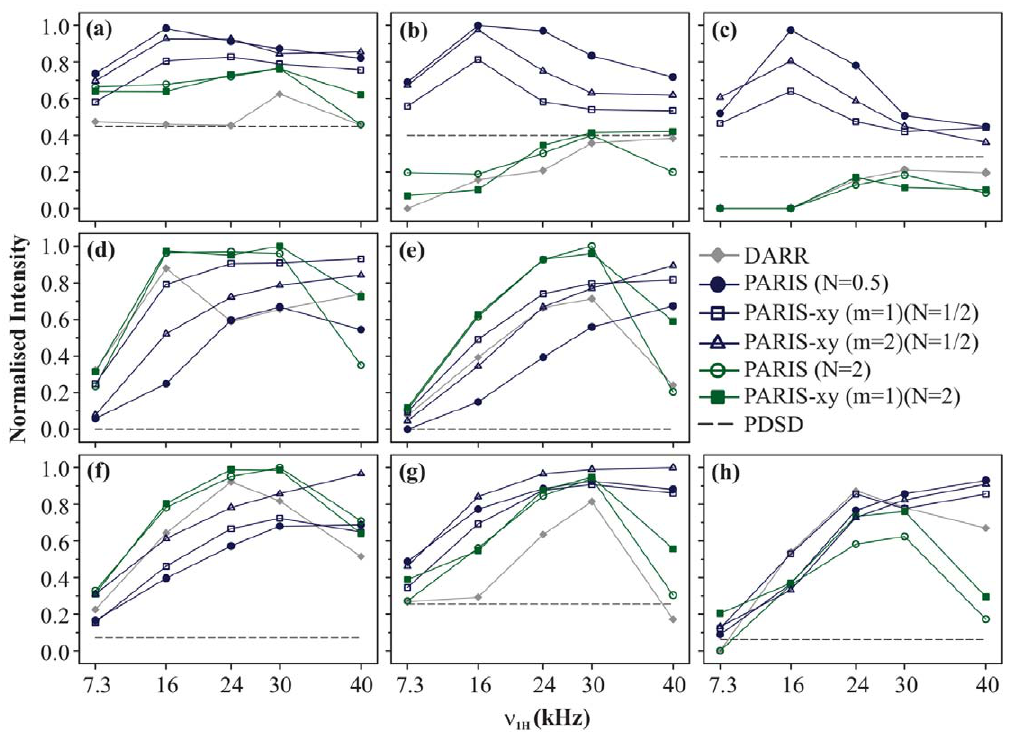
Figure 3. Build-up curves. Magnetisation build-up curves of (a) C a -C b , (b) C d -C e , (c) C e -C c , (d) C a -C c , (e) C c -CO, (f) C a -CO, (g) C b -CO, and (h) C b -C e cross-peaks of U- 13 C-, 15 N-L-histidine : H 2 O for different recoupling schemes applied on the 1 H channel, at n r =30 kHz and B 0 =16.43 T. Each recoupling scheme was applied for a fixed mixing-time period (90 ms) using different RF amplitudes of 7.3, 16, 24, 30, and 40 kHz. M values calculated for individual cross-peaks according to Eq. 1 are plotted as a function of RF amplitude. M values are normalised with respect to the maximum value yielded by PARIS (N=1/2) ( n 1 H =16 kHz) in (a, b, and c), PARIS-xy (m=1)(N=2) ( n 1 H =30 kHz) in (d), PARIS (N=2) ( n 1 H =30 kHz) in (e and f), PARIS-xy (m=2)(N=1/2) ( n 1 H =30 kHz) in (g), and PARIS (N=1/2) ( n 1 H =40 kHz) in (h). Data points are joined with straight lines to guide the readers’ eyes.